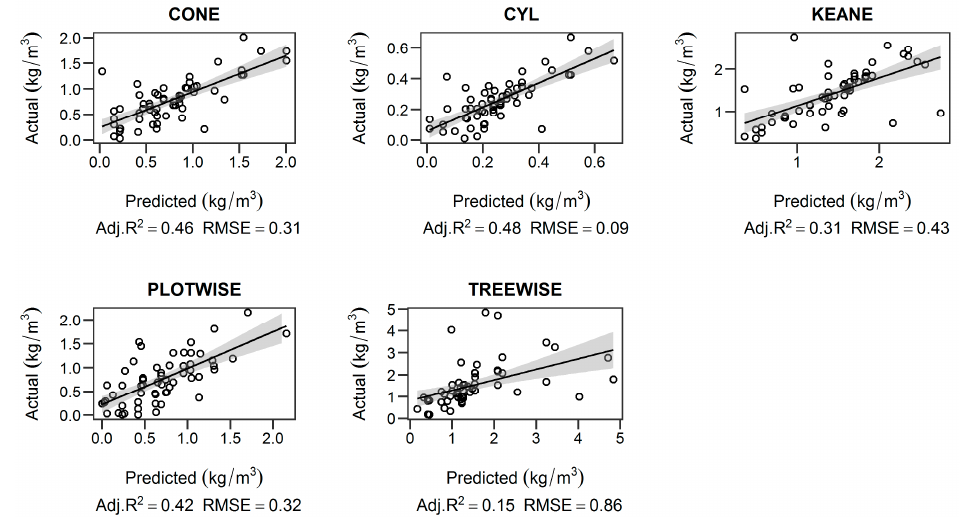
Figure 3. RandomForest k-nearest neighbor imputation model performance for five candidate canopy bulk density measurement methods. The least squares fit trend line is shown with the trend line standard error in transparent gray. Accuracy metrics are displayed in the form of the adjusted coefficient of determination (Adj. R 2 ) and the root mean squared error (RMSE).